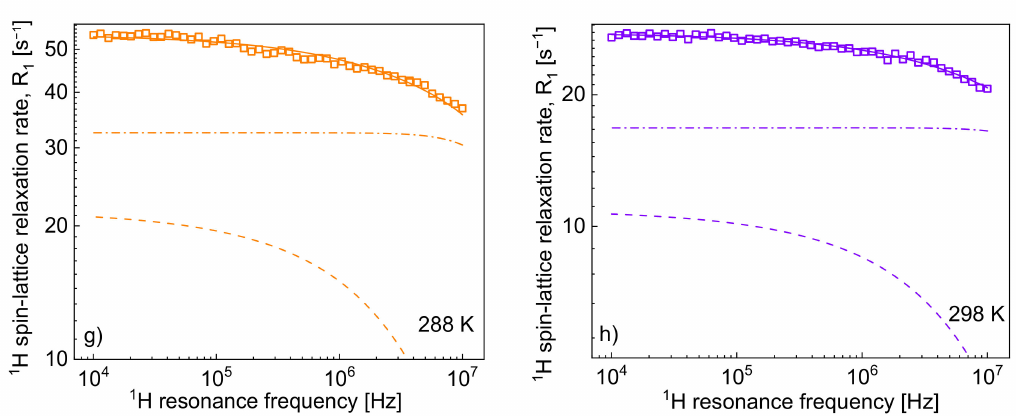
Figure 2. 1 H spin-lattice relaxation rates, R 1, H ( ω H ) , for [TEA-C4][TFSI]; solid lines—theoretical fits decomposed into ( ω ) (dashed-dotted lines) and R inter , HH R intra H 1, H